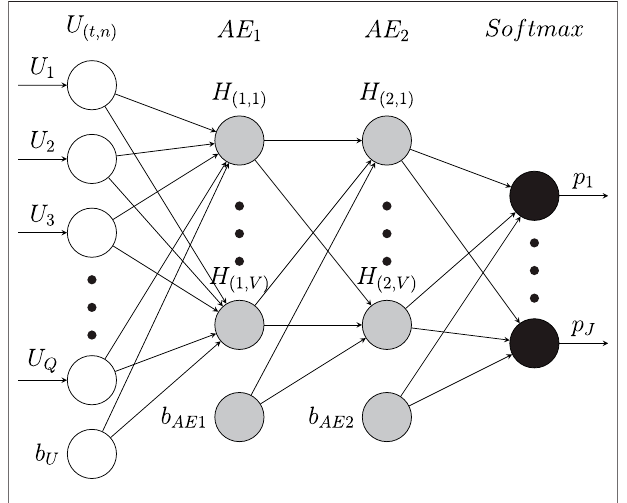
FIGURE 5 | Architecture of the used DNN n : U n , m is the input vector of featuresandabiasvector b U . AE 1 and AE 2 aretwoautoencodersandthebias vectors b AE and b AE . The softmax classi fi er gives the probability p j = j | U t , m . 1 2